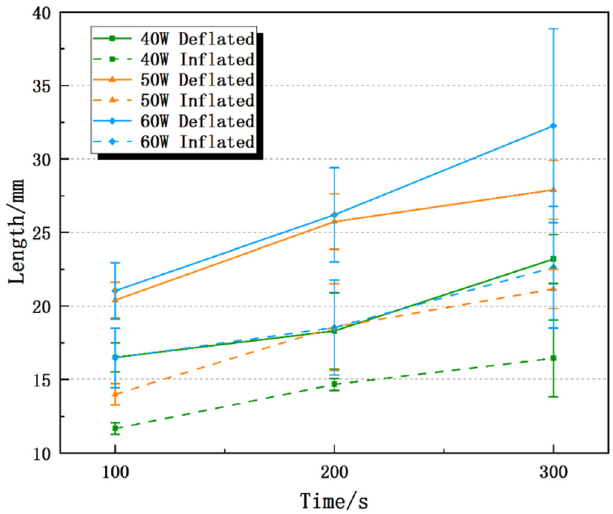
Figure 5. Average long diameter.